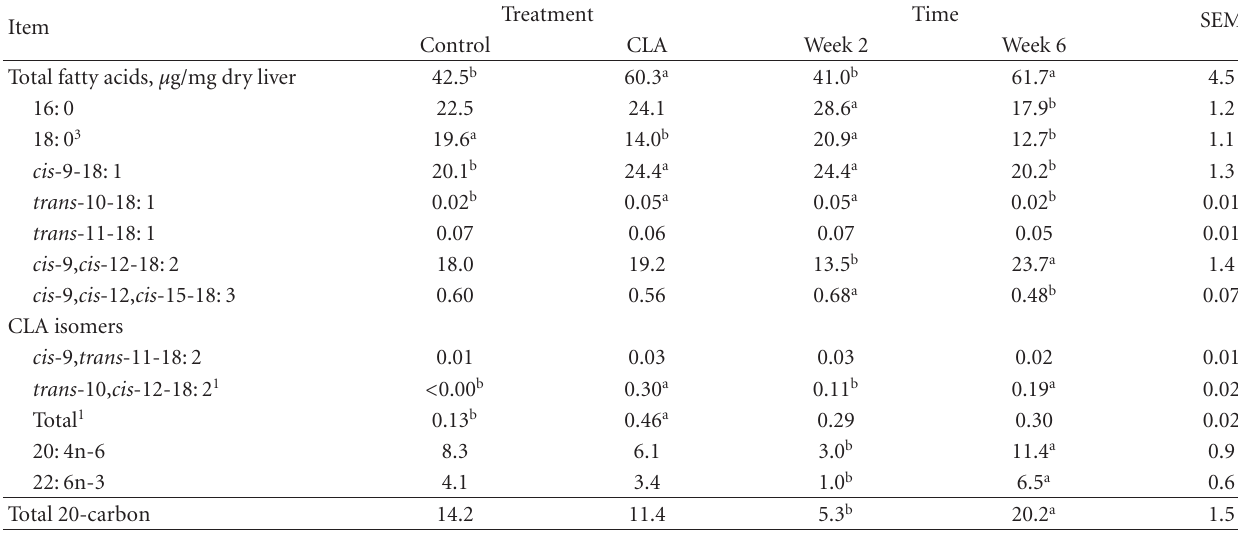
Table 3: Long-chain fatty acid concentrations in liver from mice fed control or the control supplemented with trans -10, cis -12-CLA (CLA). There were few significant interactions of treatment × time. Therefore, the results are presented according to main e ff ects (treatment and